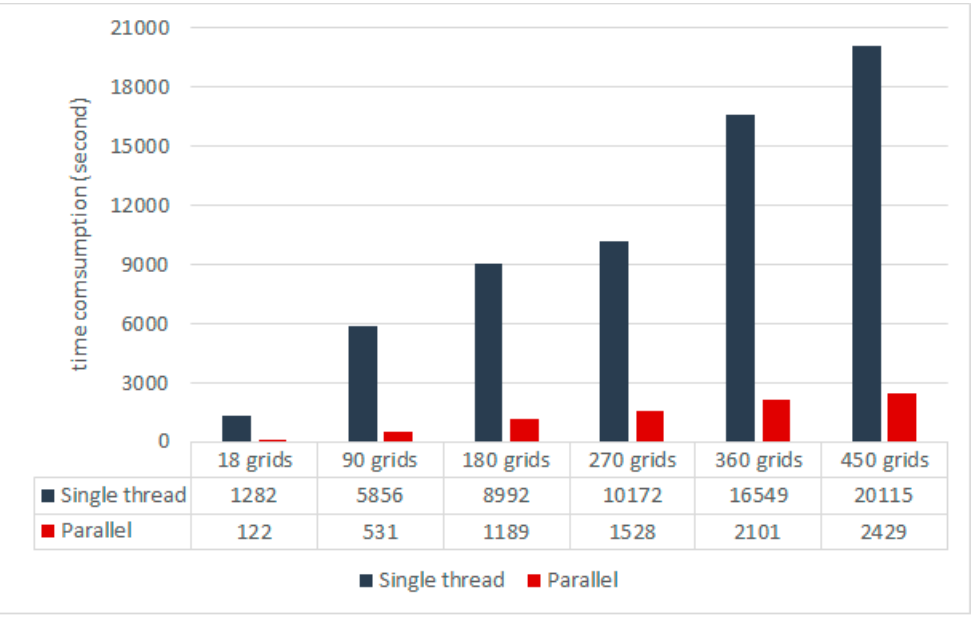
ff erent sizes of